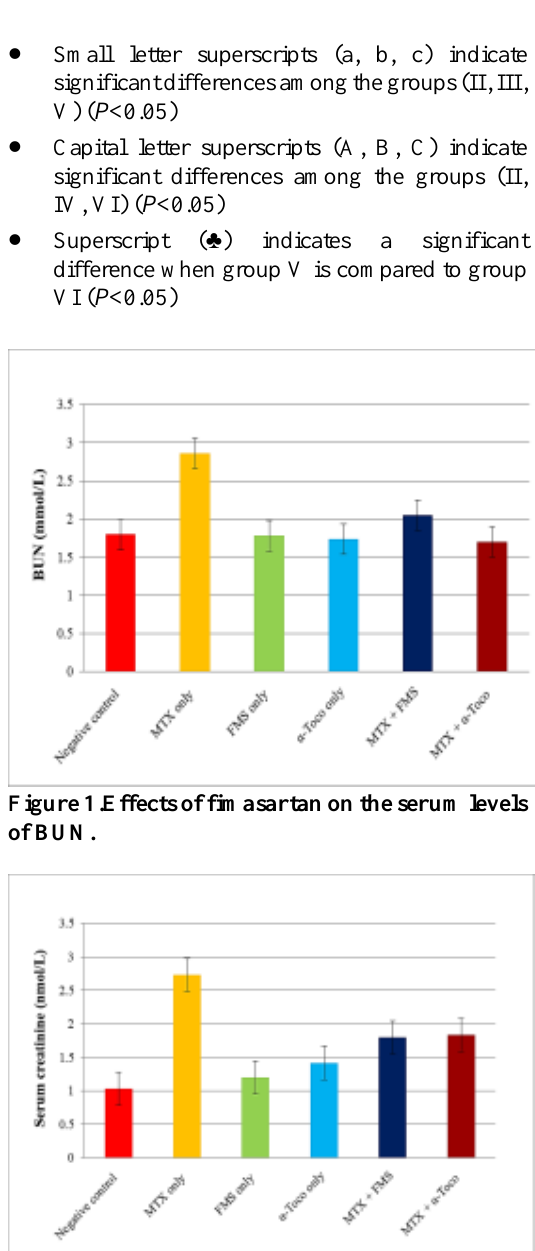
Figure 2. Effects of fimasartan on the serum levels of creatinine .